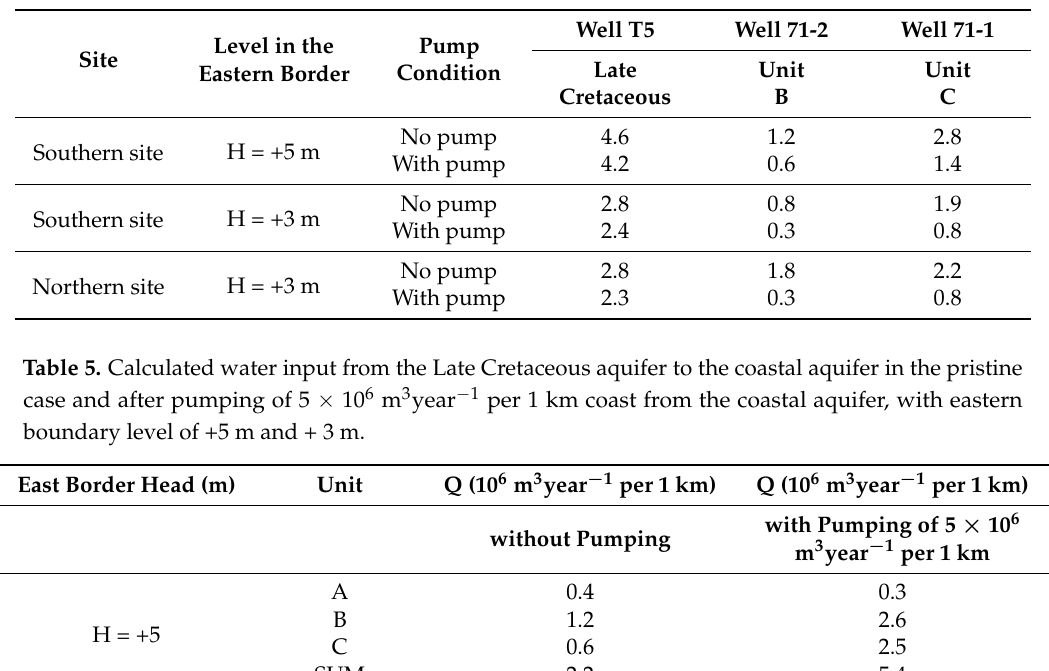
Table 4. Simulation-calculated water levels in observation boreholes, before and after pumping in the southern and northern sites under different boundary conditions. The measured levels in wells 71-1, 71-2, which represent the level after pumping, are presented in Figure 4a.